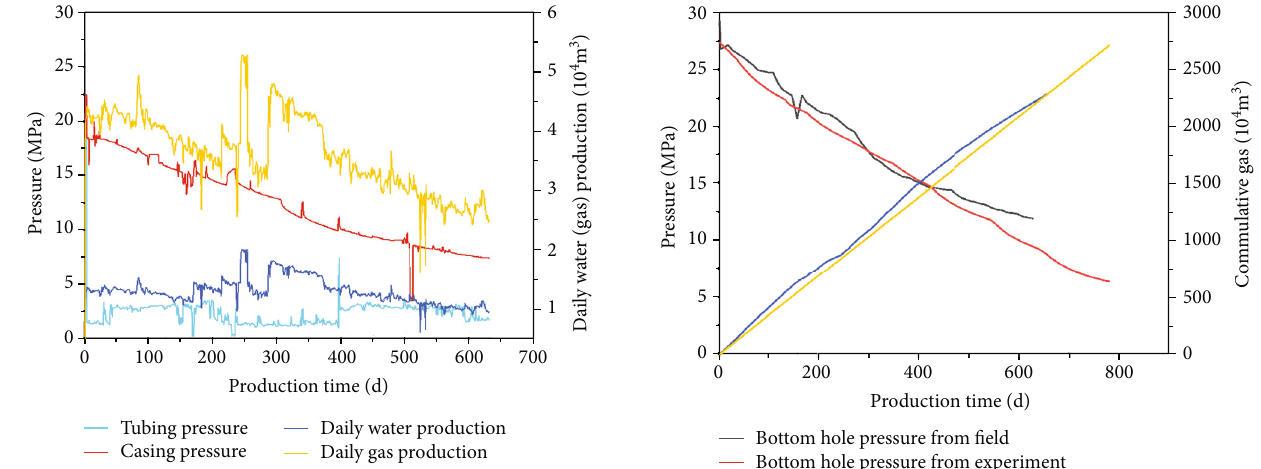
Figure 11: The production performance curve of Su-1